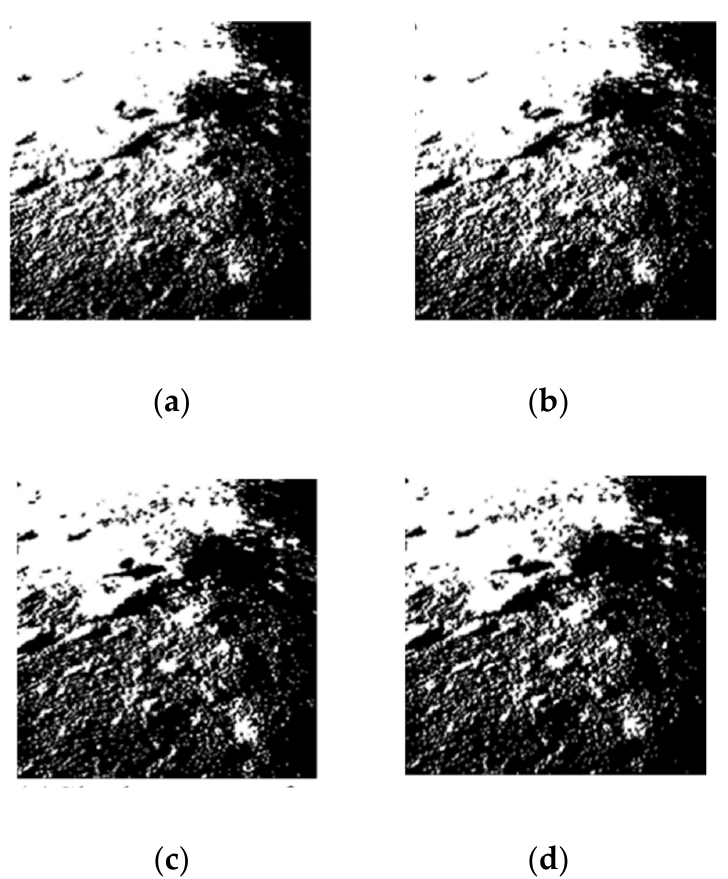
Figure 13. Shadow maps ( a ) Shadow map of image 94741, ( b ) Shadow map of image 94914, ( c ) Shadow map of image 95633, ( d ) Final shadow map.